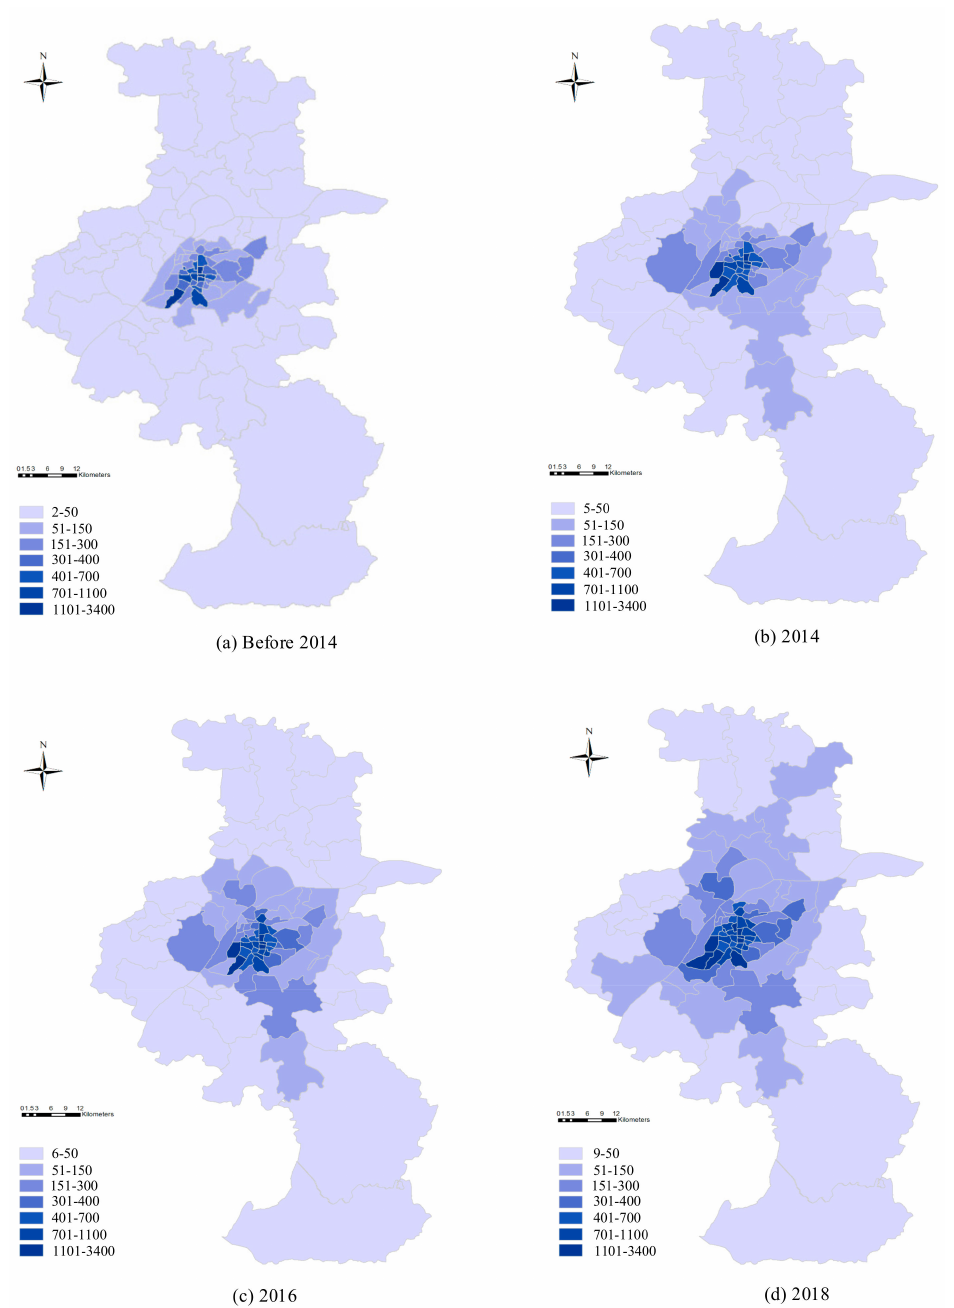
Figure 5. Subway expansion and network density at the block level. ( a – d ) show the subway network density at the block level at the end of 2013, 2014, 2016, and 2018,